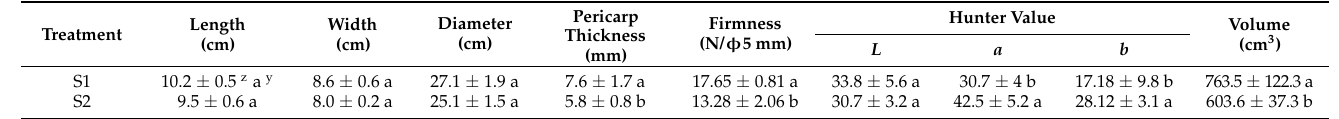
Table 2. Effect of shade screen on fruit growth characteristics of paprika in greenhouse. S1 and S2 indicate that plants were treated by single shade screen and double shade screens,